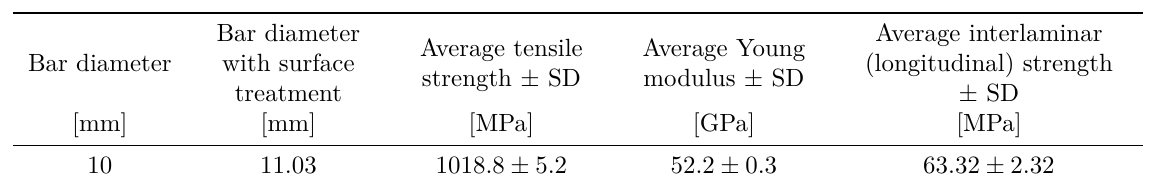
Table 1. Properties of the